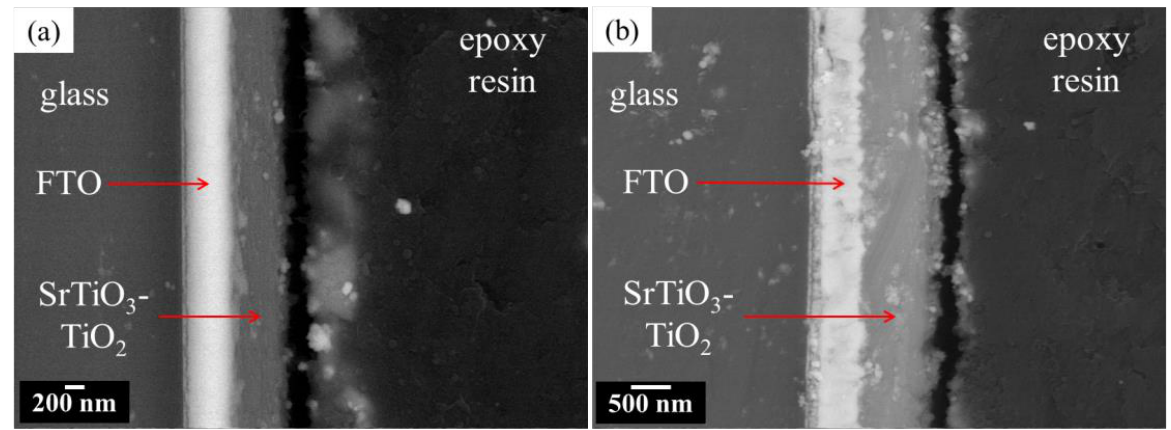
Figure 4. SEM picture made on cross-section of SrTiO 3 -TiO 2 after sputtering for ( a ) 80 min and ( b ) 220 min.